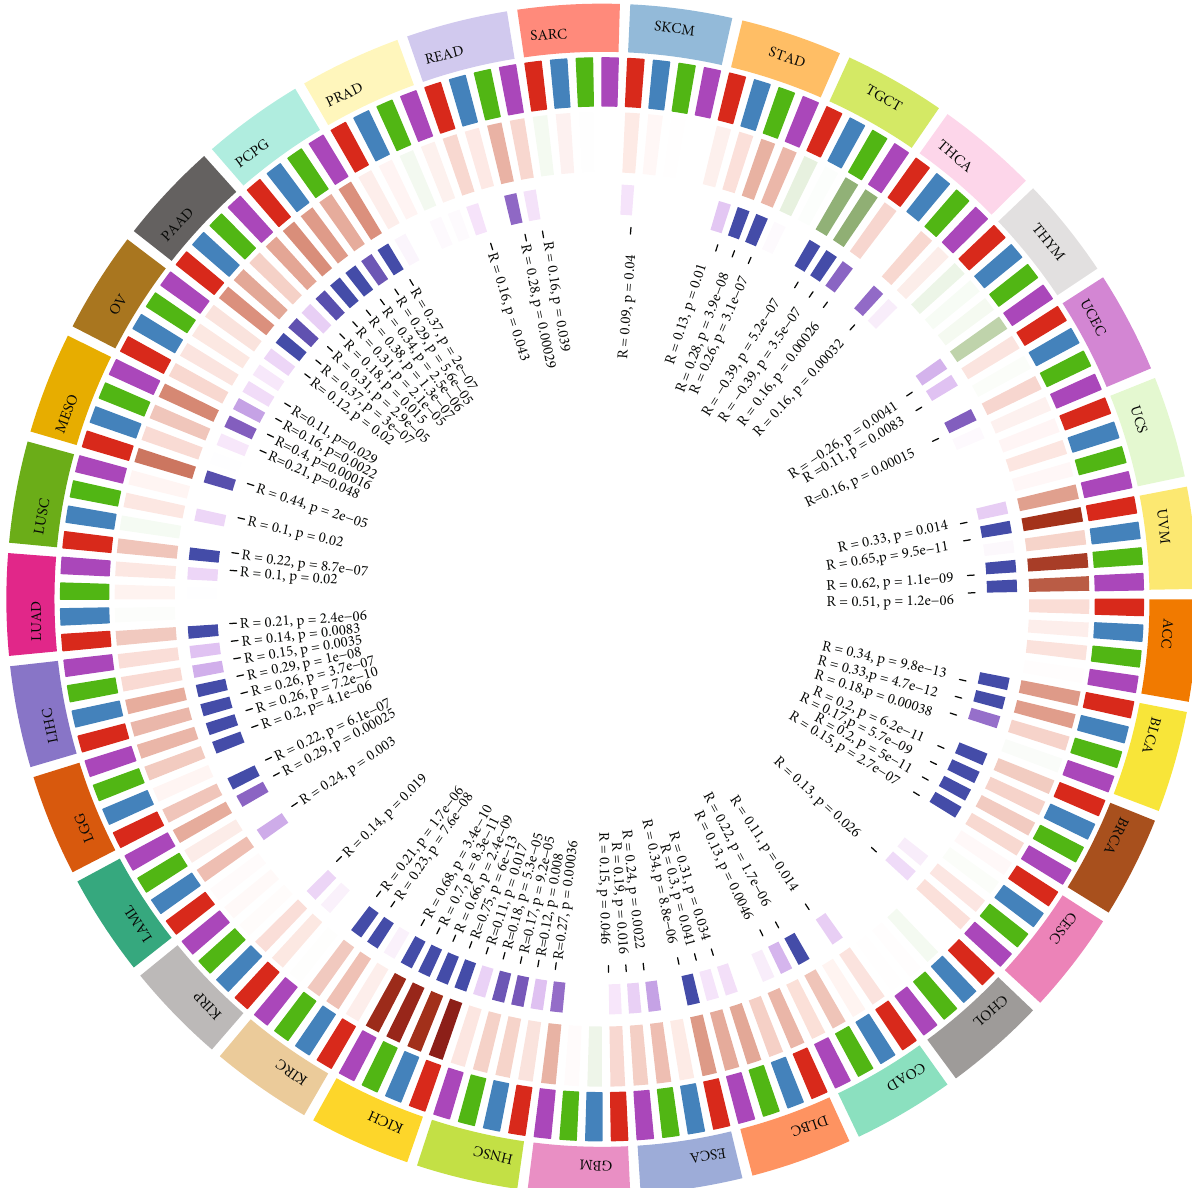
Figure 10: The Spearman ’ s correlation analysis of B4GALNT1 expression with four DNA methyltransferases across cancers. ∗ P < 0 : 05 , ∗∗ P < 0 : 01 , and ∗∗∗ P < 0 : 001 immune checkpoint genes (Figure 8). According to the results, B4GALNT1 expression showed correlations with 34 immune checkpoints genes in UVM, 33 in COAD, 29 in READ, 27 in KICH, and 26 in PAAD. The above results can lead to the con- clusion that B4GALNT1 has great signi fi cance in tumor immunity regulation. 3.5. TMB, MSI, and MMR. TMB represents the number of mutations per megabase of DNA that was sequenced in a speci fi c type of tumor and has been suggested to be identi- fi ed as a biomarker for immune checkpoint inhibitors in pan-cancer [13]. Our study revealed that B4GALNT1 expression was positively correlated with TMB in BRCA